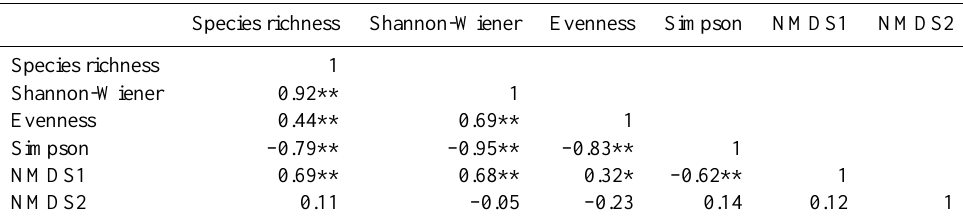
Table A2. Correlation analyses among species richness, Shannon-Wiener index, evenness index, Simpson index, NMDS1 and NMDS2 in sandy grasslands.